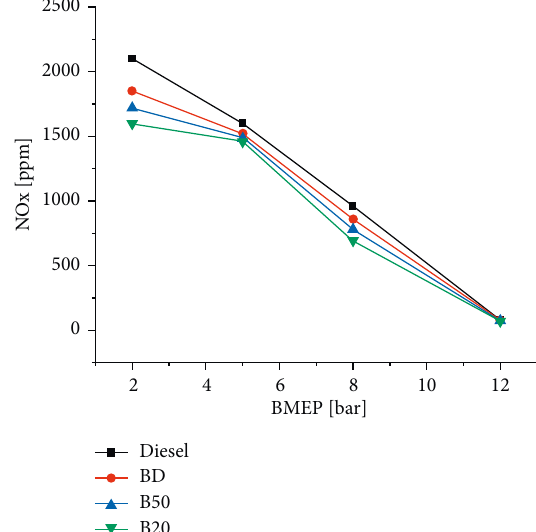
Figure 8: NOx emission with bmep @ 1500rpm.